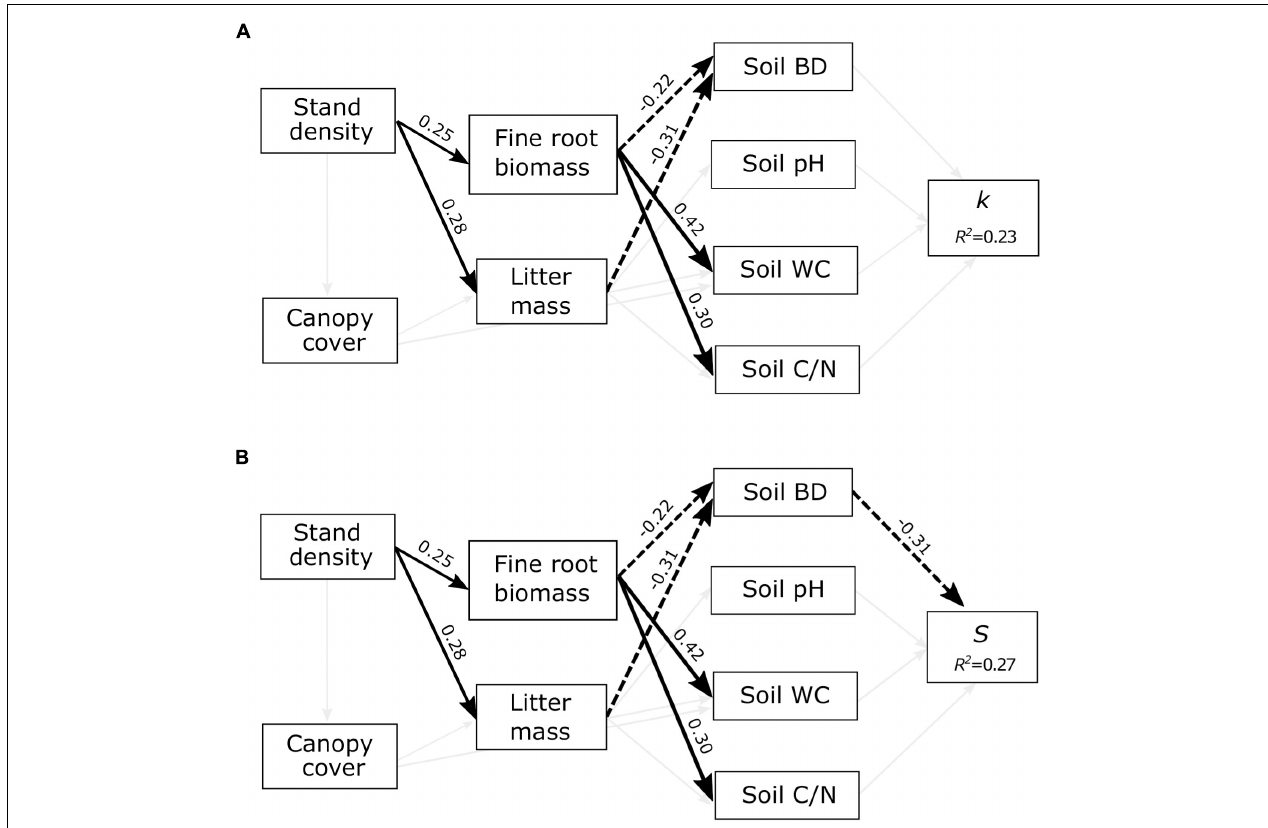
FIGURE 2 | Structural equation models showing the effects of stand structure (stand density and canopy cover), organic matter input (fine root biomass and litter mass), and soil variables (bulk density, pH, C/N ratio, and water content) on (A) the initial decomposition rate ( k ) and (B) the stabilization factor ( S ). R 2 values represent the proportion of total variance explained by the model. Significant paths are shown in black arrows with solid and dashed arrows representing positive and negative effects, respectively. Thin gray lines show tested relationships that were not